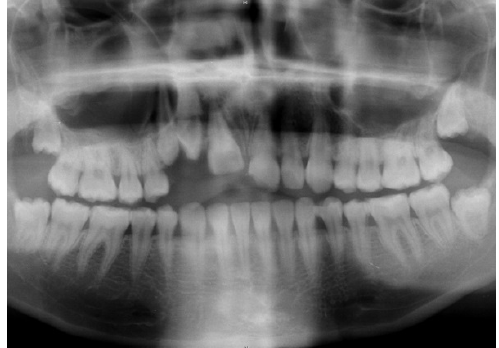
Figure 1. Panoramic radiographic investigation directly after trauma (Image: Institute of Radiology, Kantonsspital Aarau, AG, Aarau,